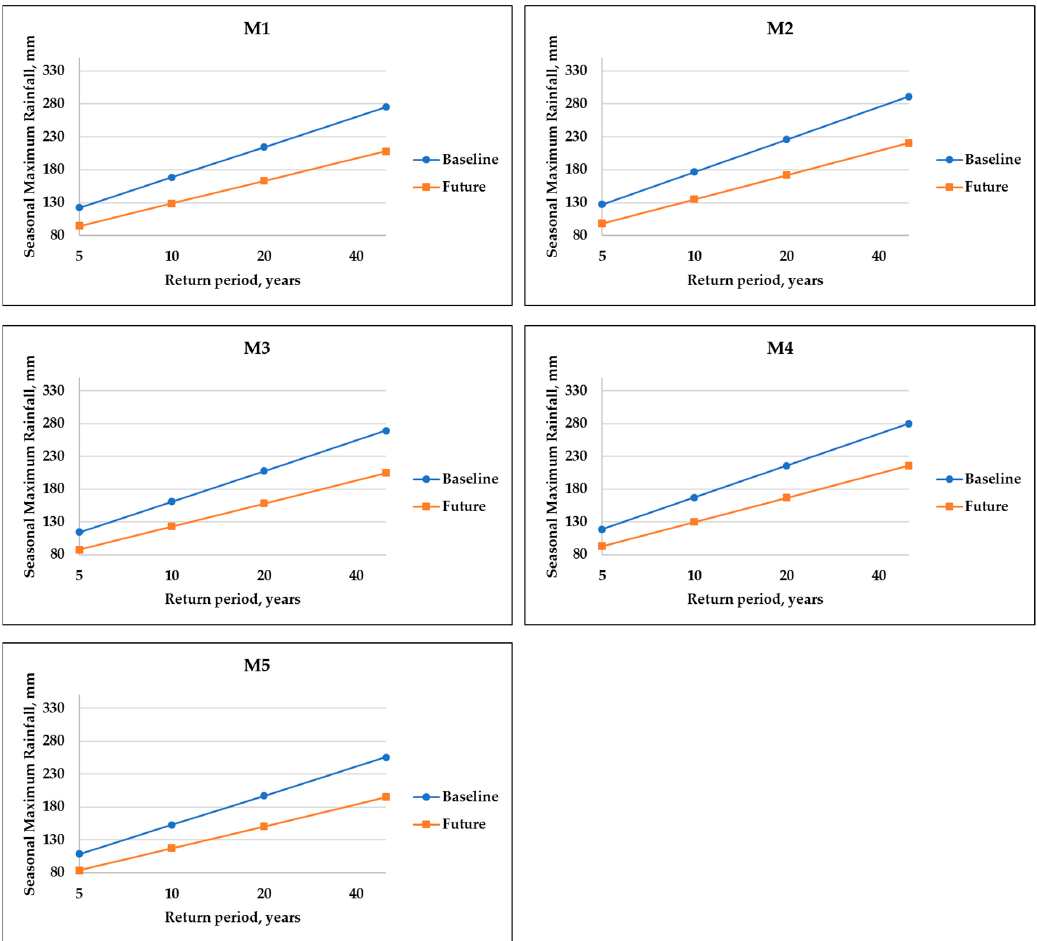
Figure 11. Return periods comparison of the maximum one day rainfall for OND